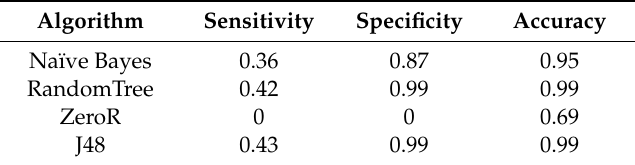
Table 4. Comparison of sensitivity, accuracy, and